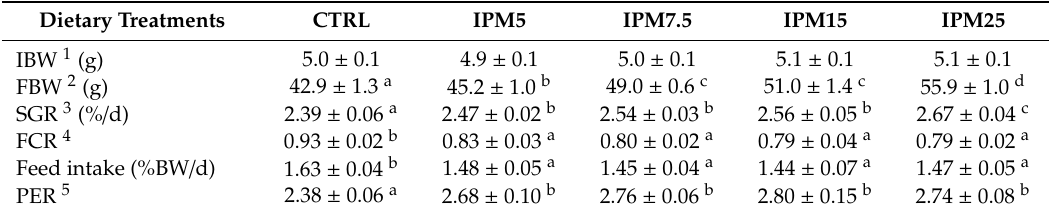
Table 2. Growth performance of rainbow trout fed the five experimental diets over 90 days (Control: CTRL, and experimental diets with 5%, 7.5%, 15%, or 25% insect protein meal (IPM), respectively IPM5, IPM7.5, IPM15, and IPM25). Values are means ± standard deviations ( n = 3). Di ff erent superscript letters indicate significant di ff erences ( p < 0.05) between experimental treatments. Dietary Treatments CTRL